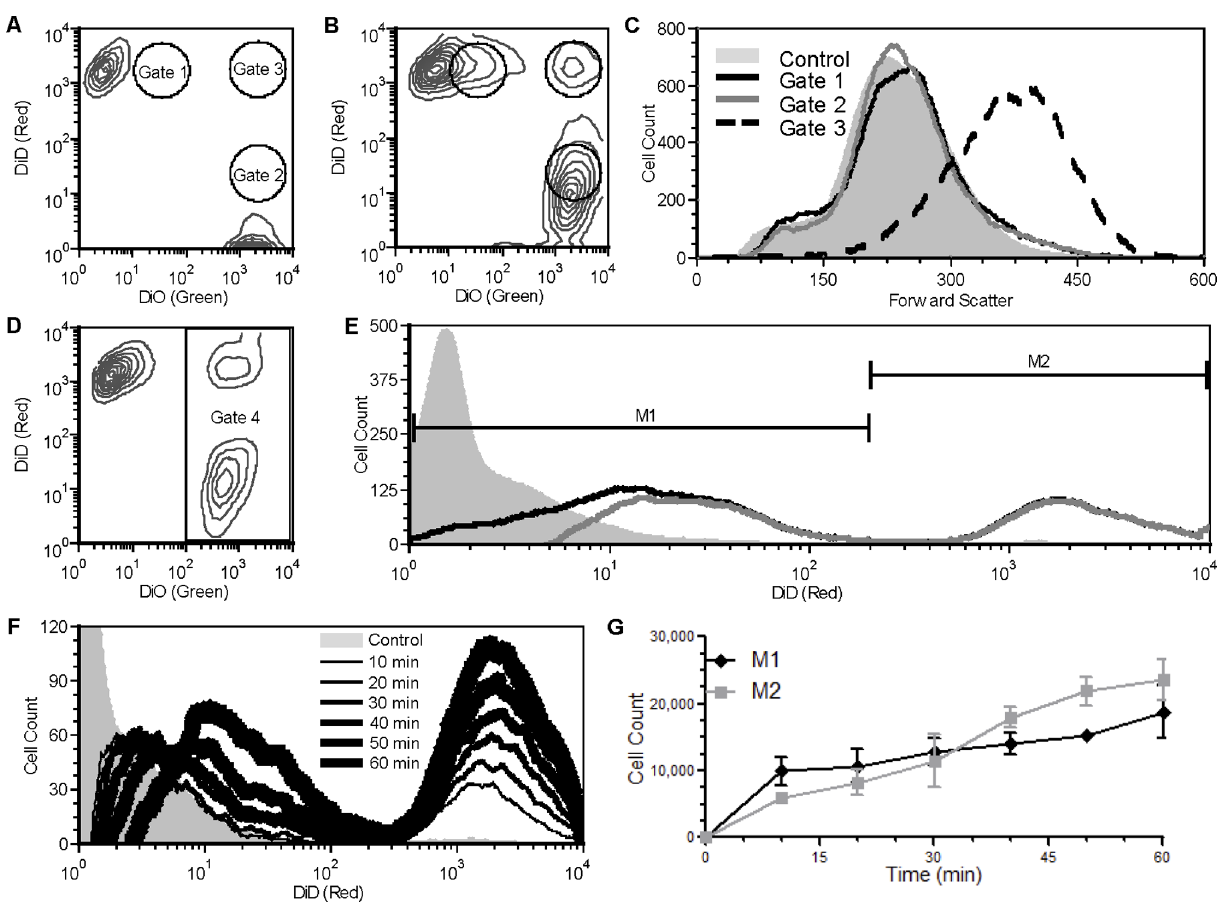
Figure 2. Flow cytometry analysis of stained Jurkat cells. Analysis by flow cytometry of mixed DiO (10 m M) and DiD (5 m M) stained Jurkat cells, showing the green fluorescent/DiO and red fluorescent/DiD profiles with relative positions of gates 1, 2, & 3: A . Untreated (1 hr at 37 u C). B . PTxM treated (7.9 nM for 1 hr at 37 u C). C. Analysis of cells showing the forward scatter profiles of the ungated cells in panel A (control) and gated cells in panel B. D. Mixed DiO- (5 m M) and DiD- (5 m M) stained PTxM-treated cells showing the green fluorescent/DiO and red fluorescent/DiD profiles and the position of gate 4. E. Red fluorescent/DiD profiles of untreated (grey field) and PTxM-treated (black line) Jurkat cells from Gate 4, and Overton subtraction of untreated from treated (grey line). Transfer (M1) and aggregation (M2) events are indicated. F. Analysis by flow cytometry of Jurkat cells showing the red fluorescent/DiD profiles of the Gate 4 cells with no treatment (grey field) and a time course for PTxM treatment from 10 min (thinnest black line) to 60 min (thickest black line). G. Comparison of the mean transfer (M1, black line) and aggregation (M2, grey line) population sizes of three independent assays with standard deviation. Gate 1 as Green d + /Red + , and Gate 2 as Green + /Red d + . Non-